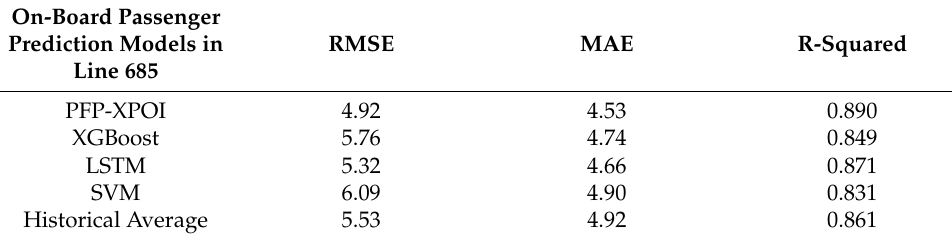
Table 4. Evaluation values of different models for on-board passenger prediction in line 685.